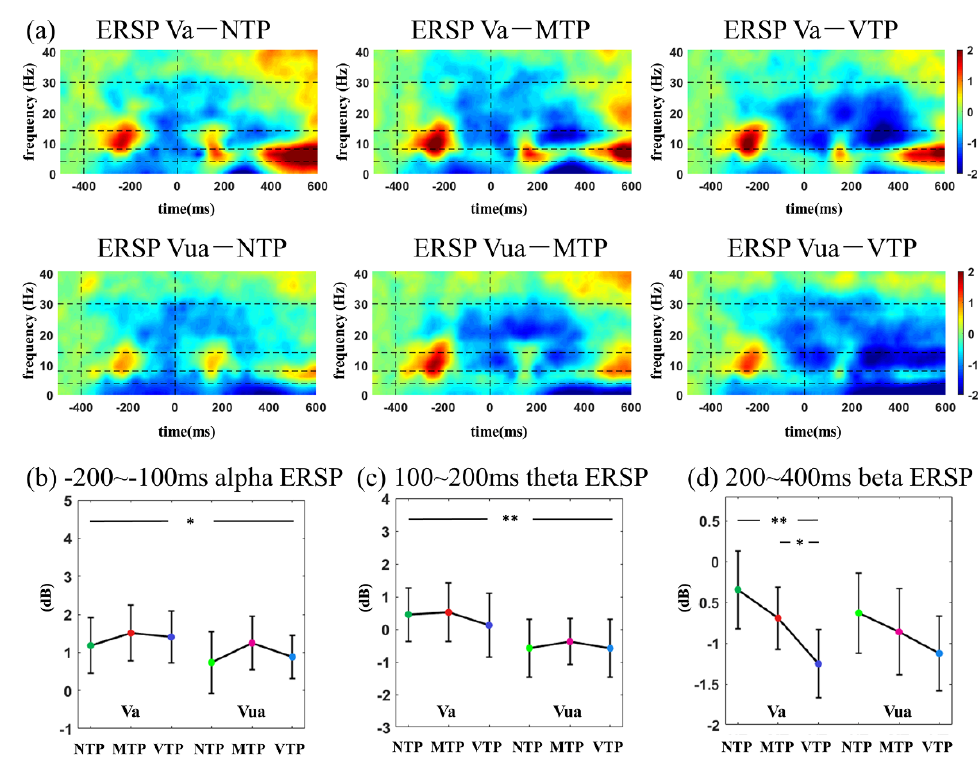
Figure 7. ( a ) ERSP time–frequency distributions in visual modality; comparisons among distinct MA-TP conditions of ( b ) − 200– − 100 ms alpha ERSP; ( c ) 100–200 ms theta ERSP; ( d ) 200–400 ms beta ERSP. Statistical significance: * 0.01 < p < 0.05; ** 0.001 < p < 0.01. ERSP time-frequency distributions in auditory modality can be found in Figure 8. In the − 200 to − 100 ms period, auditory attention enhanced alpha ERSP ( F (1,26) = 7.059, p = 0.013, η 2 = 0.214). After the second beep, an increased ERSP first emerged, but showed p no difference among conditions. Then, there was a beta suppression, which revealed a MA = 0.294). main effect ( F (1,26) = 10.813, p = 0.003, η 2 p MA led to larger alpha ERSPs in both the visual and auditory modalities after the first stimulus onset. After the second stimulus, attention increased theta ERSP. Beta differences induced by the TP were only found in Va